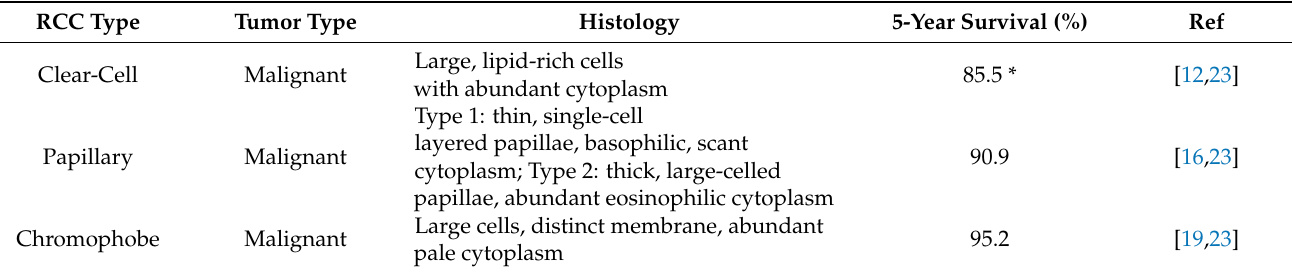
Table 1. Renal Cell Carcinoma